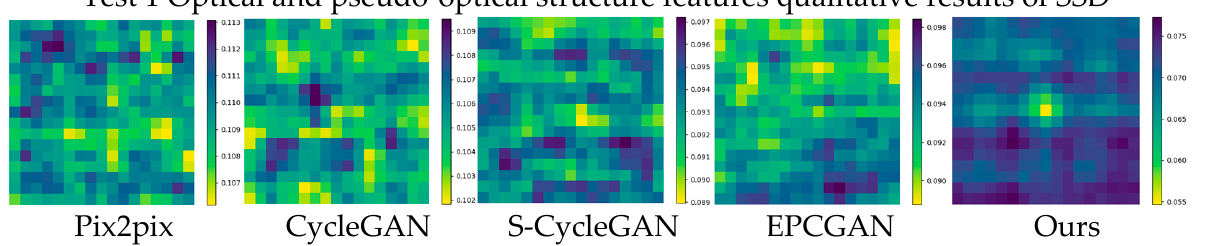
Figure 10. Test 1: qualitative similarity comparison of the structural features of the real optical image and the pseudo-optical images obtained using different SAR-to-optical image translation methods.